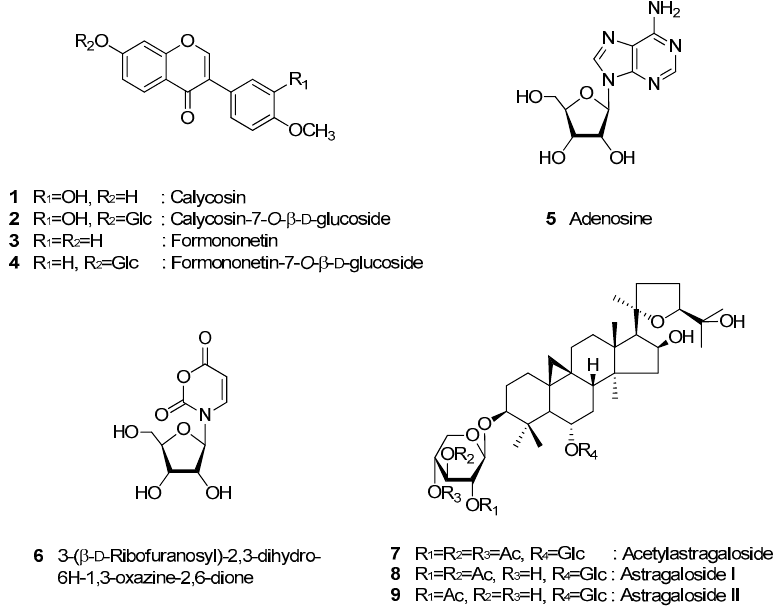
Figure 1. Chemical structures of compounds 1 – 9